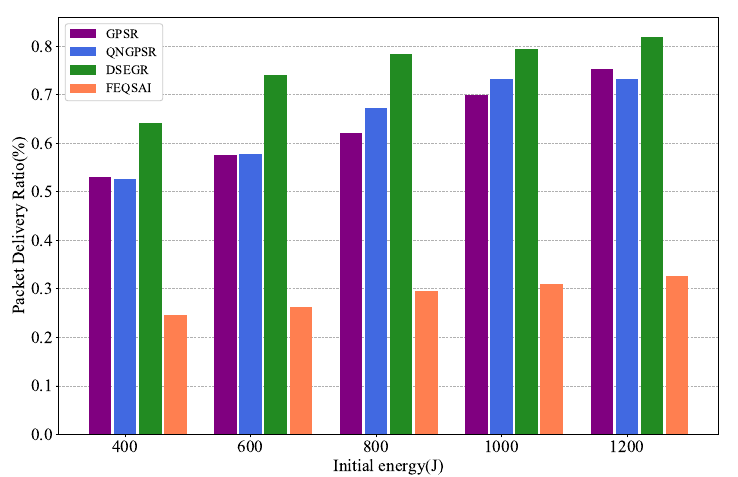
Figure 15. Performance comparison of PDR among GPSR, QNGPSR, DSEGR, and FEQSAI with different initial packet